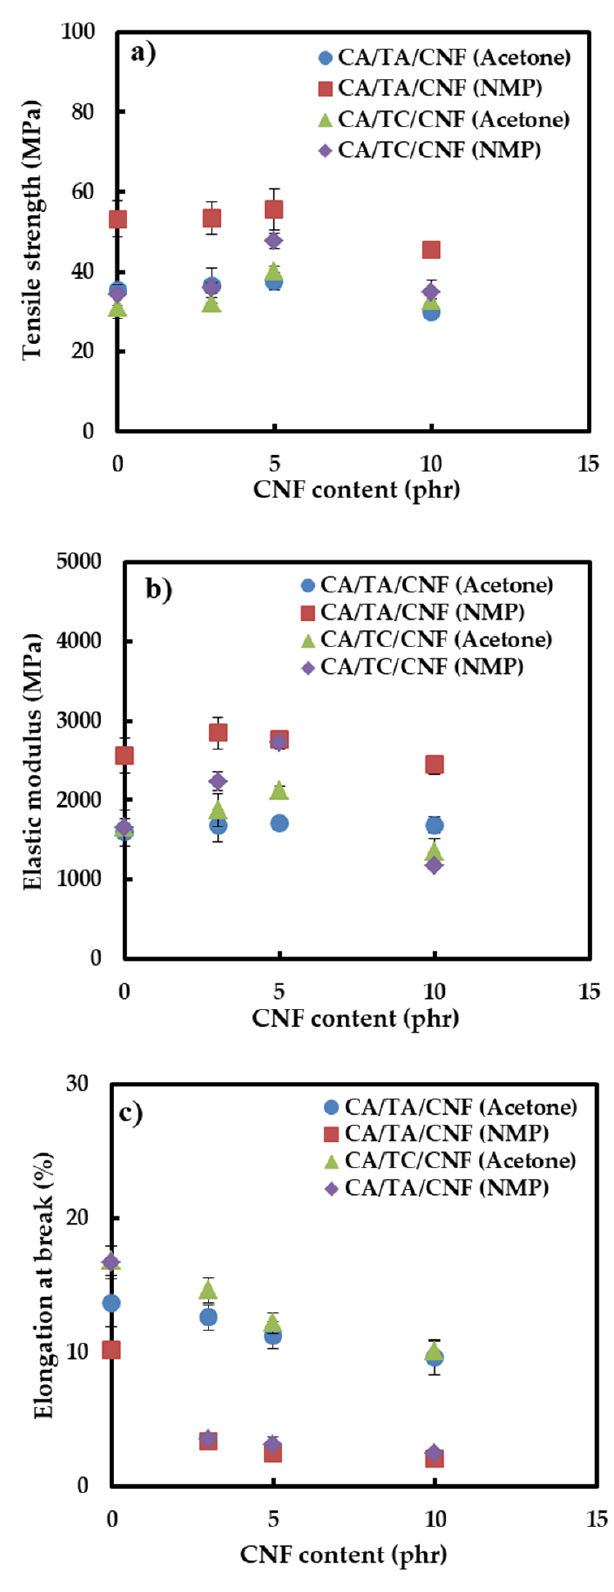
Figure 2. Tensile strength ( a ), elastic modulus ( b ), and elongation at break ( c ) of CA/TC/CNF and CA/TA/CNF in acetone and NMP solvent (Plasticizer content 30%).